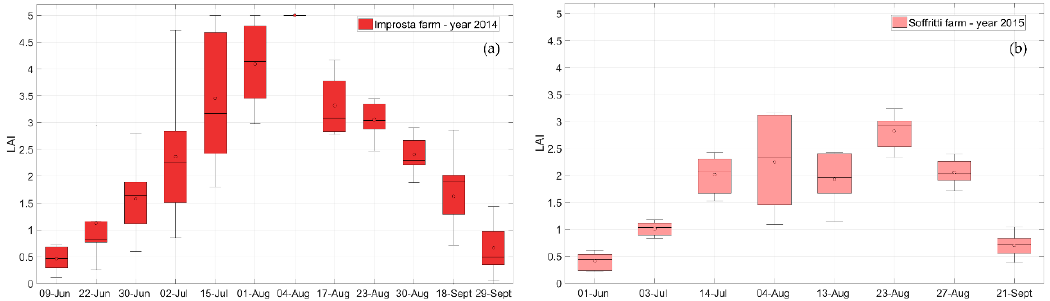
Figure 6. The leaf area index (LAI) at ( a ) Improsta and ( b ) Soffritti farms retrieved from remote multispectral satellite images.